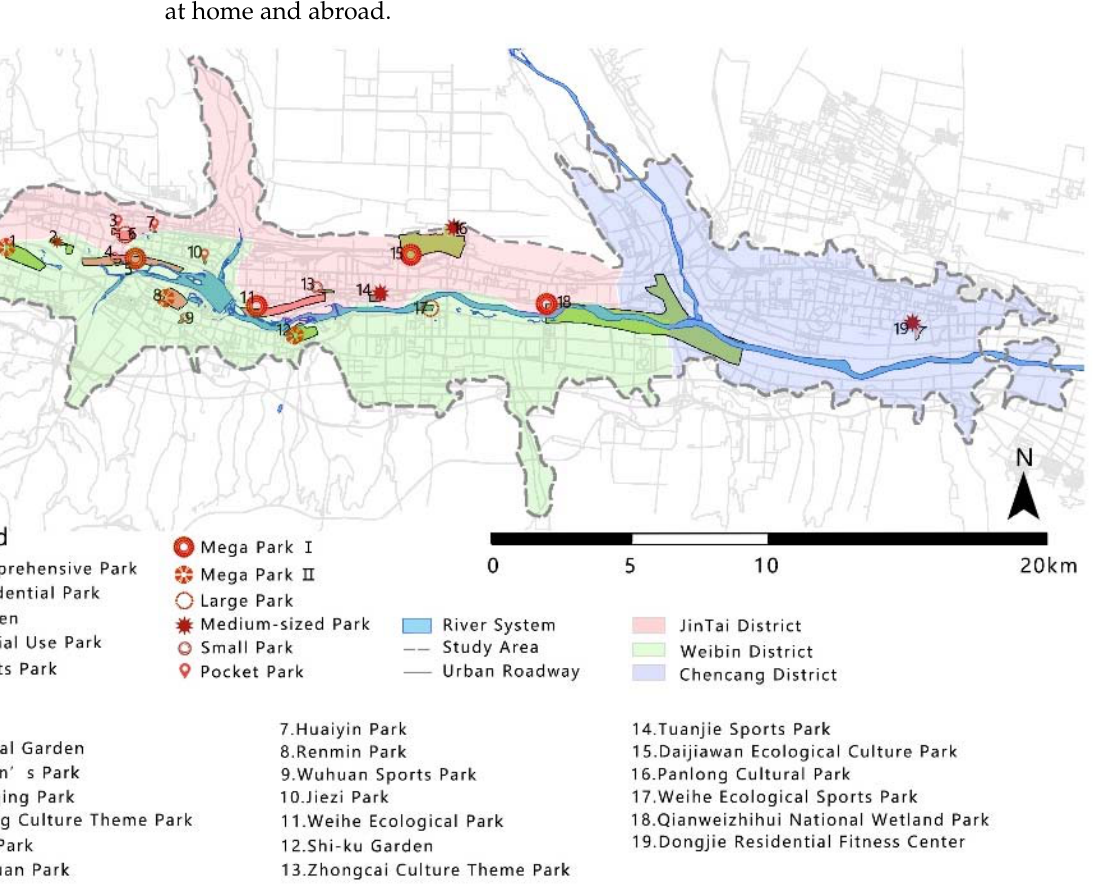
Figure 1. The location of urban parks in the study area.